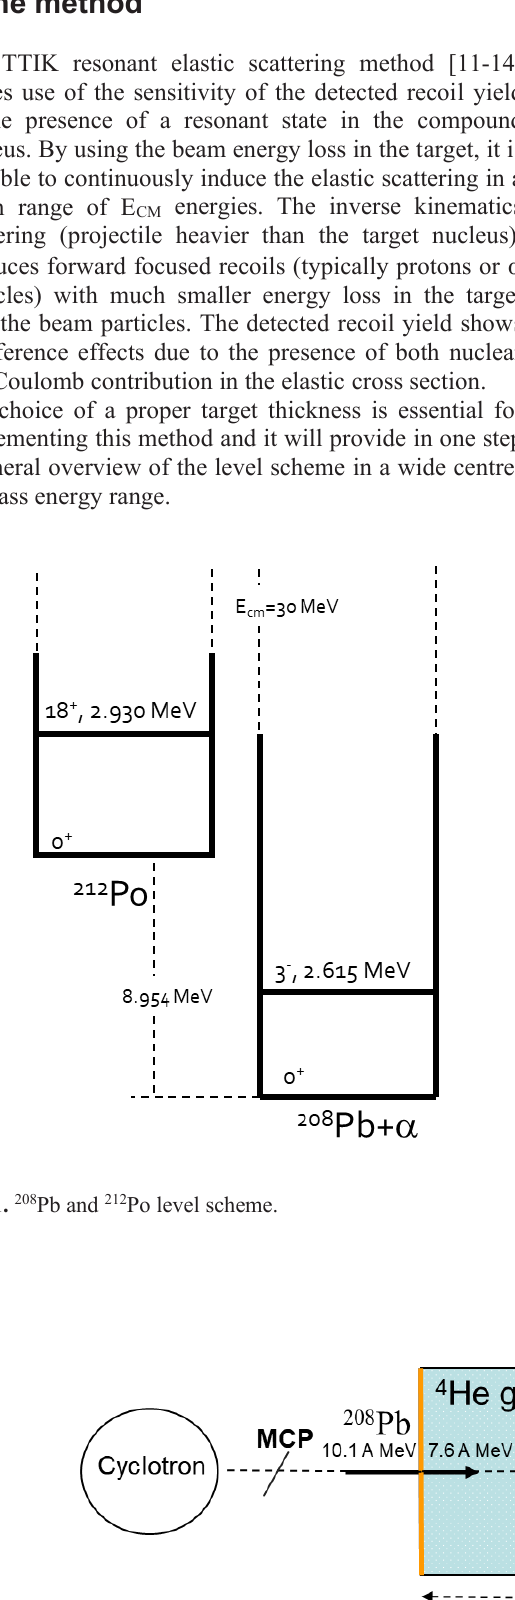
Fig. 2. Experimental set-up